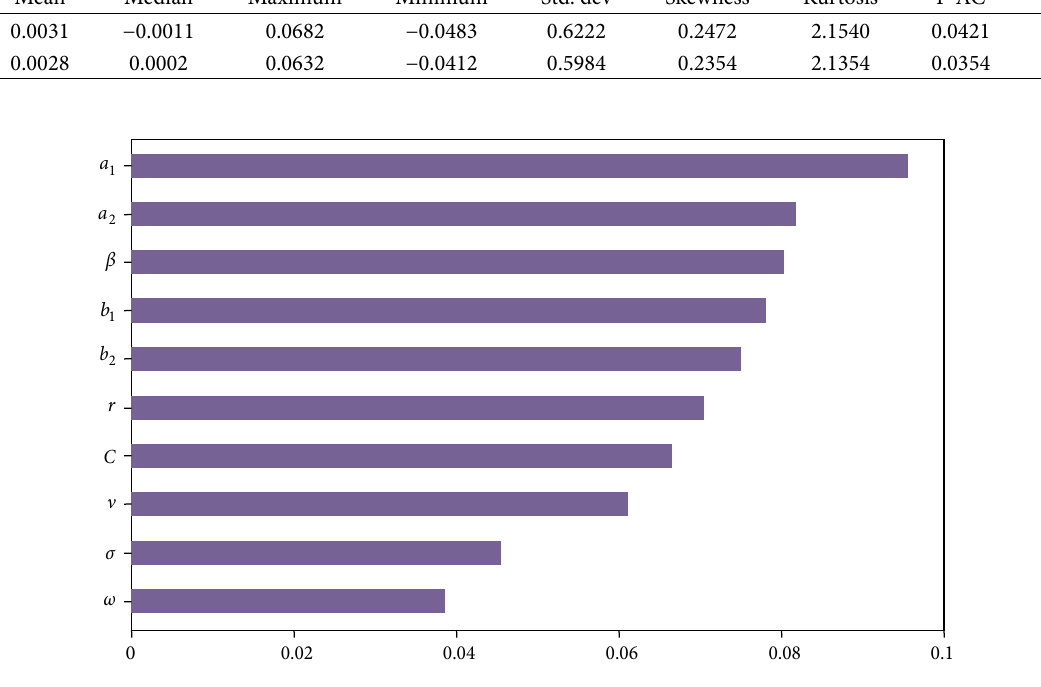
Figure 3: Parameter importance